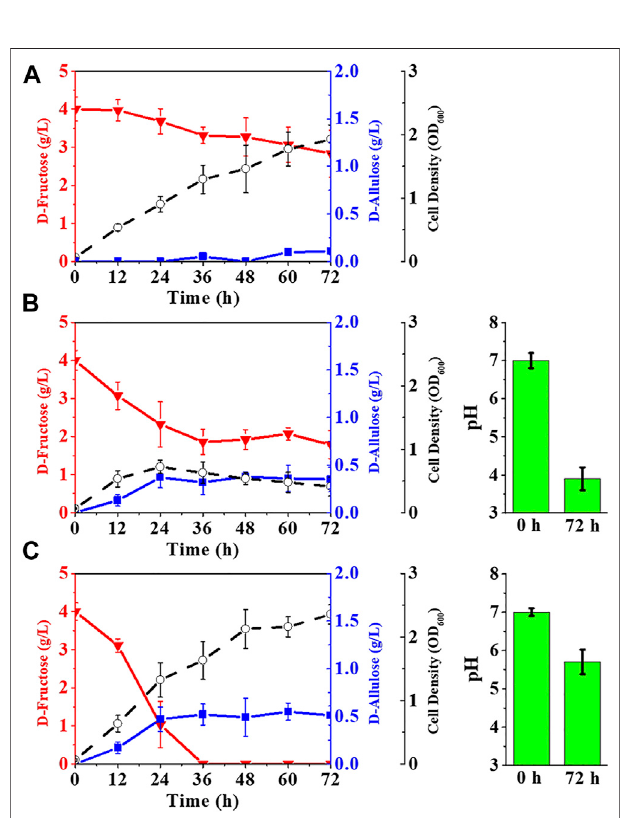
FIGURE 4 | Reprogramming of fructose transport pathways in E. coli to enhance D-allulose production. E. coli cells were cultured in LB medium with 4.00 g/L D-fructose at 37 ° C. (A) E. coli ( alsE , a6PP , Δ fruA ), (B) E. coli ( alsE , a6PP , ptsG - F , mak , Δ fruA ), (C) E. coli ( alsE , a6PP , ptsG - F , mak , Δ fruA ) with 100 mM potassium phosphate. Error bars, SD , n = 3 .